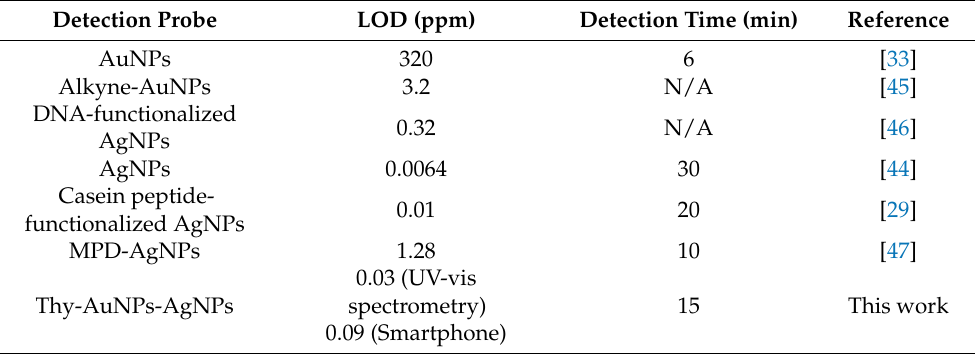
Table 1. Comparison of colorimetric detection probes for Cu 2+ based on AuNPs and AgNPs, and this Thy-AuNP-AgNP hybrid sensing system. Detection Probe LOD (ppm) Detection Time (min) Reference AuNPs 320 6 [33] Alkyne-AuNPs 3.2 N/A [45] DNA-functionalized 0.32 N/A [46] AgNPs AgNPs 0.0064 30 [44] Casein peptide- 0.01 20 [29] functionalized AgNPs MPD-AgNPs 1.28 10 [47] 0.03 (UV-vis Thy-AuNPs-AgNPs spectrometry) 15 This 0.09 (Smartphone)